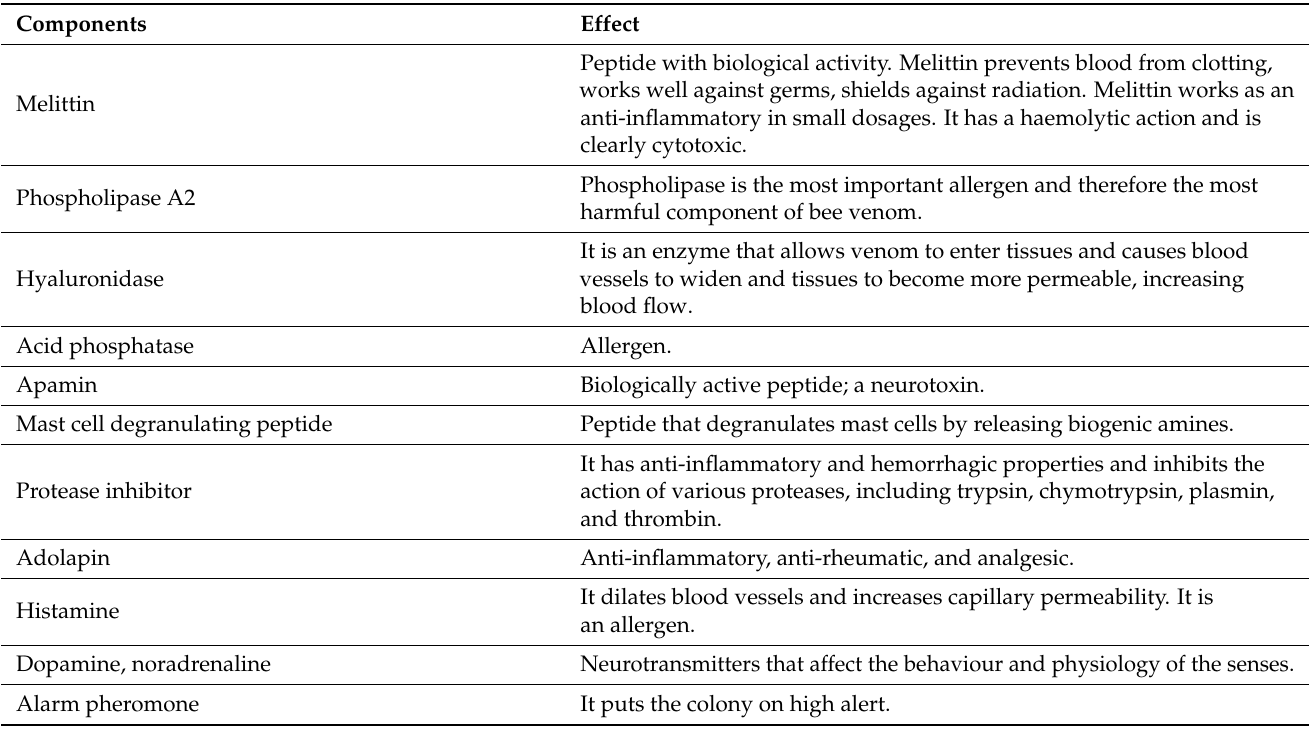
Table 2. Biological effects of bee venom and its